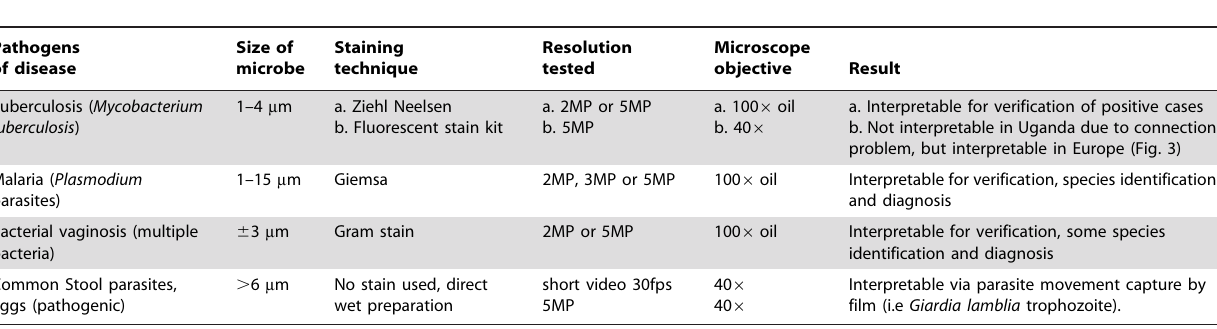
Table 2. Microscopy diagnostic applications and mobile phone camera resolutions